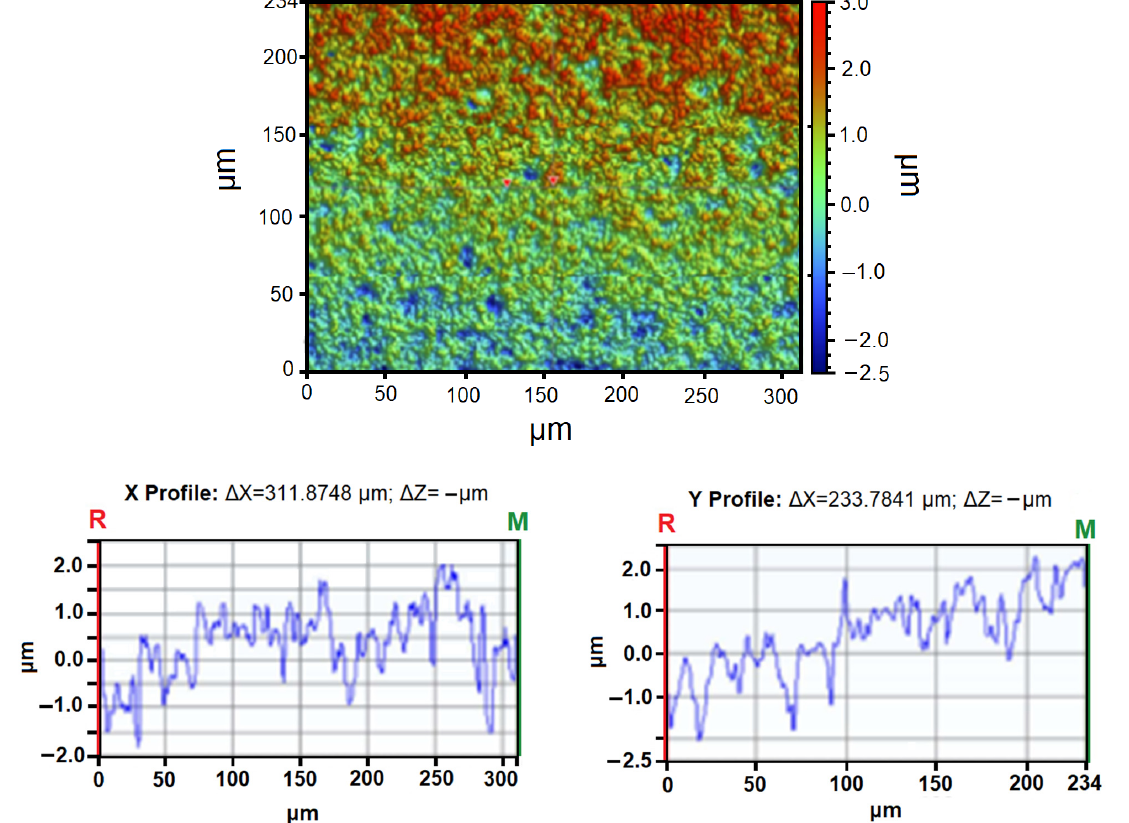
Figure 10. Images of rough silicon substrate with deposited NiCr 280 nm film.